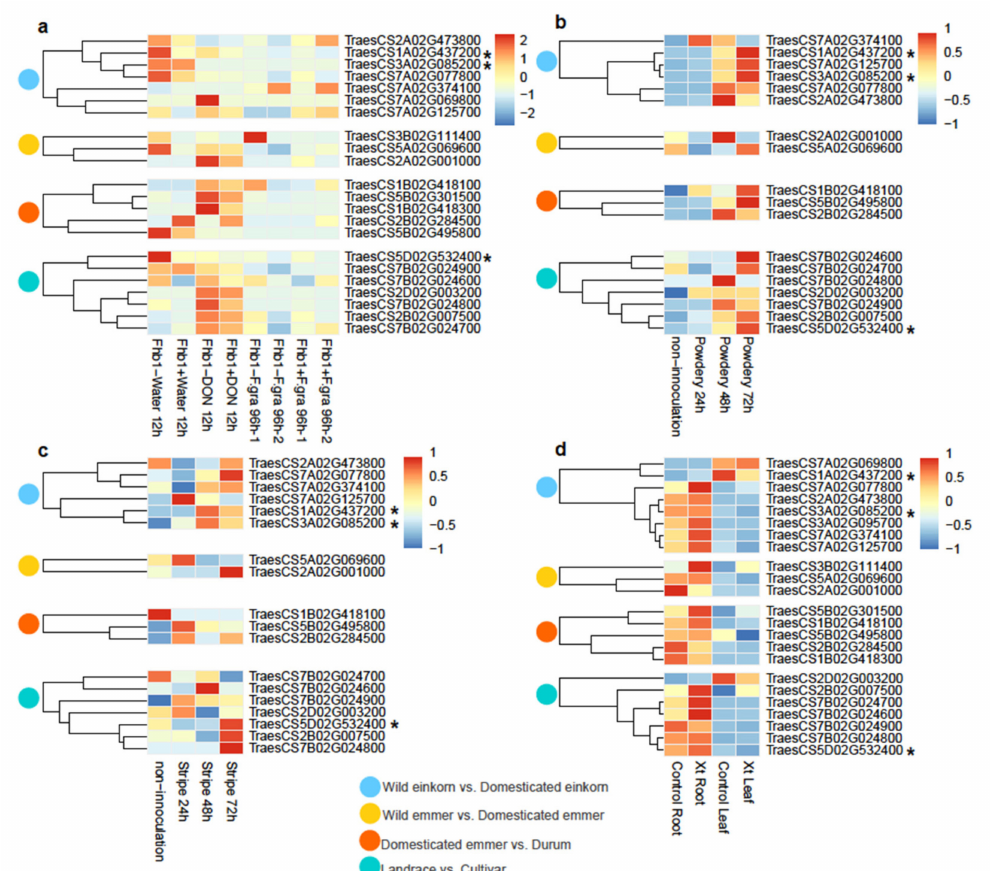
Figure 6. The expression heatmaps of selected NLR genes from four comparisons. Red cells indicate higher expression levels and blue cells represent lower expression levels. Blue circles represent wild einkorn vs. domesticated einkorn; yellow circles represent wild emmer vs. domesticated emmer; red circles represent domesticated emmer vs. durum; green circles represent landrace vs. cultivar. The asterisks beside the gene IDs represent the NLR genes involved in stripe rust resistance reported by Cristobal’s group (Ram í rez-Gonz á lez et al., 2018). ( a ) The expression heatmap from the Fusarium graminearum infects wheat spikes and causes Fusarium head blight (FHB). Fhb1+ represents resistant lines and Fhb1 − represents susceptible lines. − 1 and − 2 represent two replications; ( b ) the expression heatmap from the powdery mildew pathogen innoculation; ( c ) the expression heatmap from stripe rust pathogen innoculation; ( d ) the expression heatmap from Xanthomonas translucens (Xt) pathogen infection. Plants inoculated with water were used as controls. Data was downloaded from http://202.194.139.32/expression/wheat.html (accessed on 28 June 2021). This figure was generated using the R package “pheatmap”. Genes without expression data are not shown. The experiment was carried out with three biological replications, and average values of the three replications were used to plot the